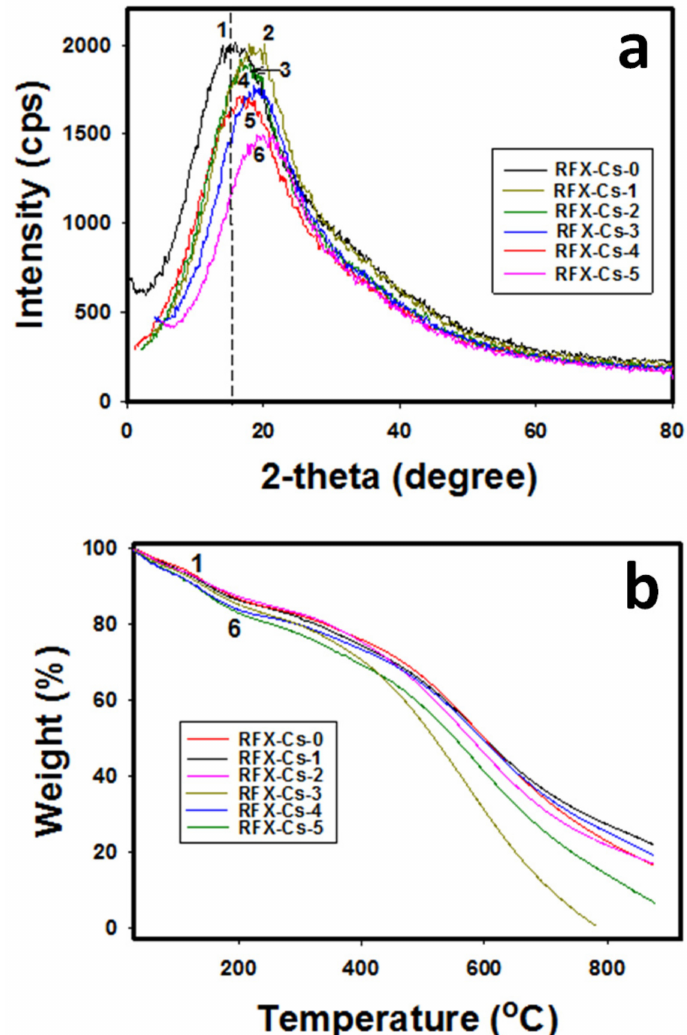
Figure 2. ( a ) XRD patterns and ( b ) TGA thermograms of the samples RFX–Cs-0 through RFX–Cs-5 (curves 1 through 6,